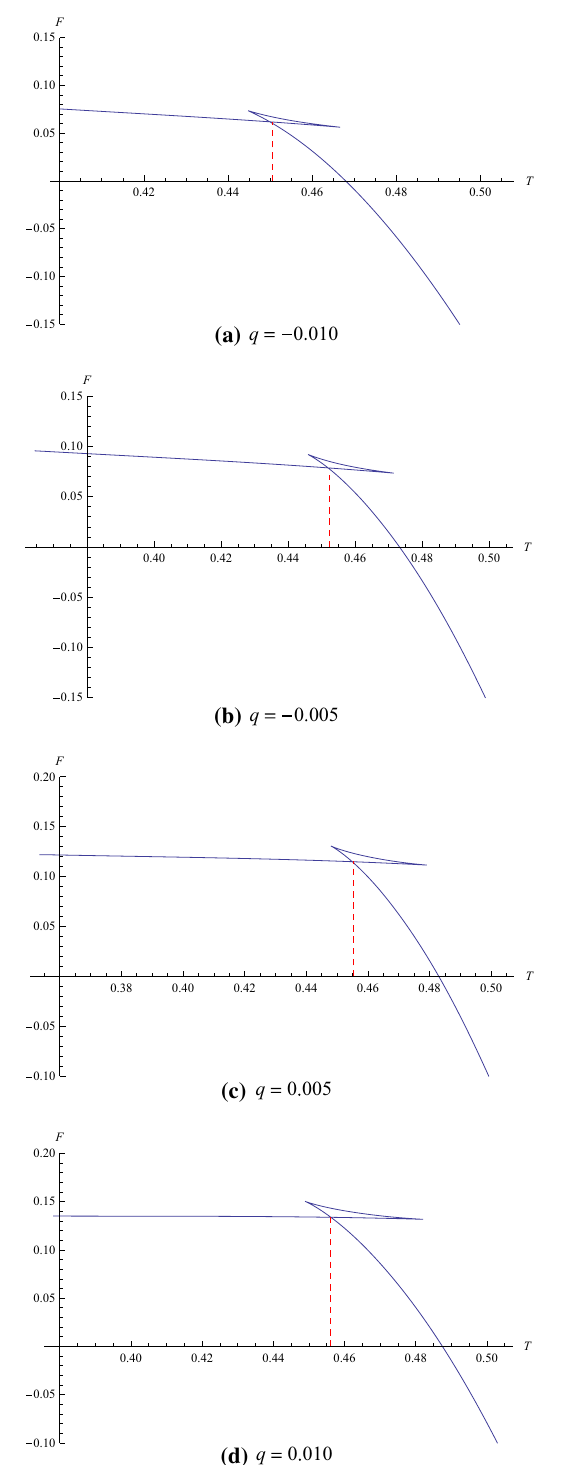
Fig. 2 Plots of the temperature versus the free energy for different q in the case of Q < Q C . In each graph, the red dash line indicates a first order phase transition temperature T ∗ . a Q = 0 . 0286384 and T ∗ = 0 . 4506. b Q = 0 . 0338006 and T ∗ = 0 . 4524. c Q = 0 . 0429513 and T ∗ = 0 . 4552. d Q = 0 . 0470977 and T ∗ = 0 . 4561